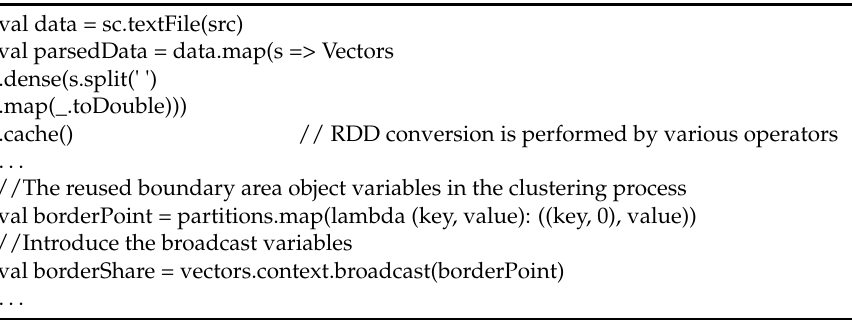
Table 3. Optimization Method One—the pseudo codes after the data transmission